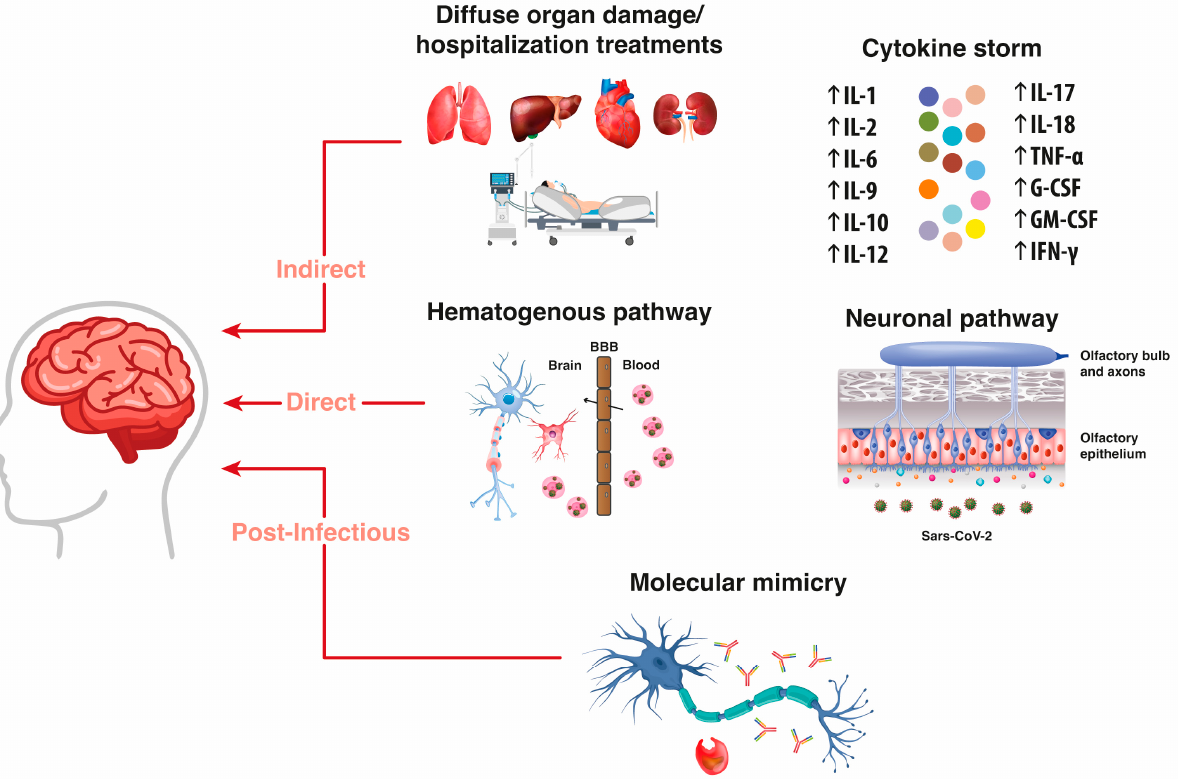
Figure 1. Indirect, direct and postinfectious mechanisms of neurotoxicity due to SARS-CoV-2 infection. The indirect mechanisms result from pulmonary, hepatic, cardiovascular, and renal injuries, as well as from the side effects of hospitalization treatments. Indirect neurotoxicity may derive also from an abnormal host response called “cytokine storm”, characterized by an increased release of pro-inflammatory cytokines. The direct mechanisms of SARS-CoV-2 neurotoxicity originate from the straight viral diffusion into the brain through the hematogenous pathway and/or the neuronal pathway. The hematogenous pathway consists of the entry of peripheral immune infected cells into the brain by the blood–brain barrier (BBB). In the neuronal pathway, viruses reach the nerve endings and, by a mechanism of retrograde active transport, reach the central nervous system by a synapse-connected route. Here, the entry through the olfactory epithelium and olfactory nerve is shown. Post-infectious mechanisms stem mainly from molecular mimicry between human coronaviruses and myelin basic protein (antibodies attacking myelin sheath and a phagocytosing macrophage are represented).